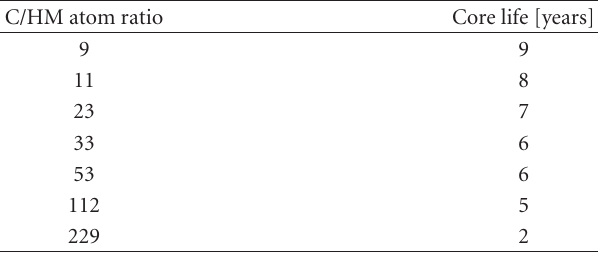
∗ Packing fraction of 30% corresponds to the C/HM ratio of 138 (12467 particles per